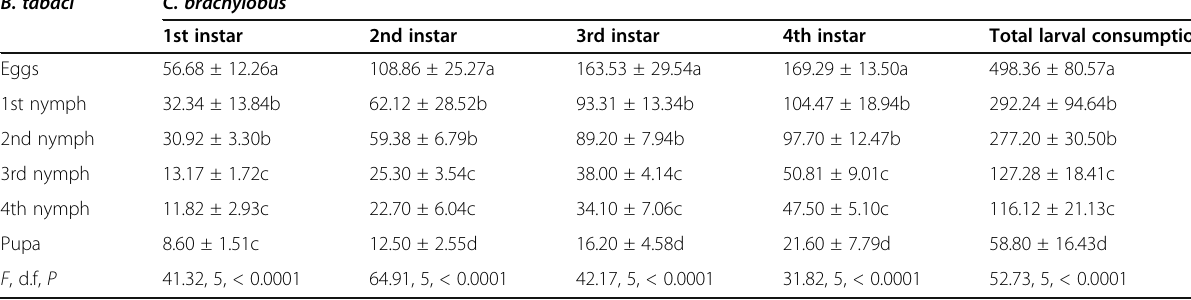
Table 2 Average prey consumption (mean ± SE) by C. barchylobus immatures